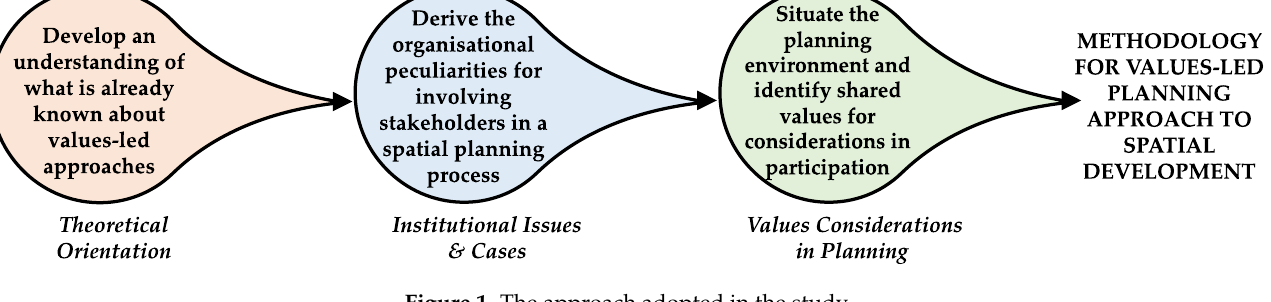
Figure 1. The approach adopted in the study.